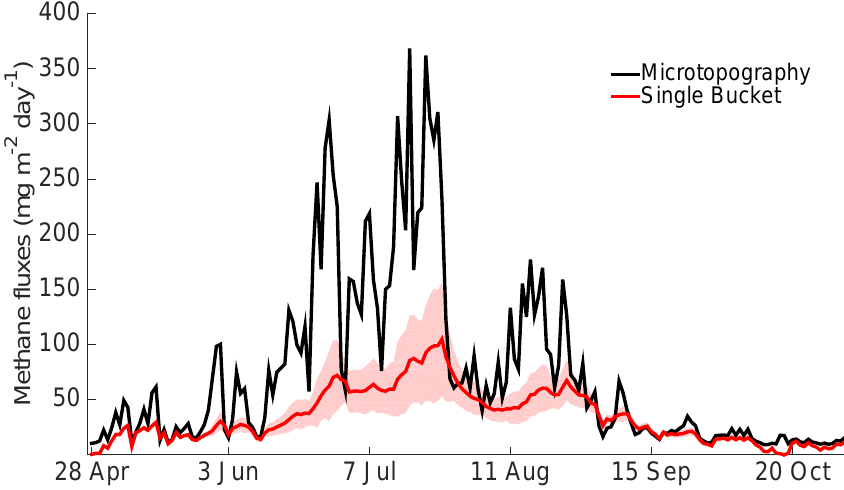
Figure 6. Ensemble simulations of methane emissions averaged over the whole model domain. mWe compare the Microtopography version of the model (black line) with the Single Bucket model version (red line). We show the average of 30 ensemble runs (solid lines) and the shaded areas represent the standard deviation among the runs (but their small size renders them invisible in the microtopography case).